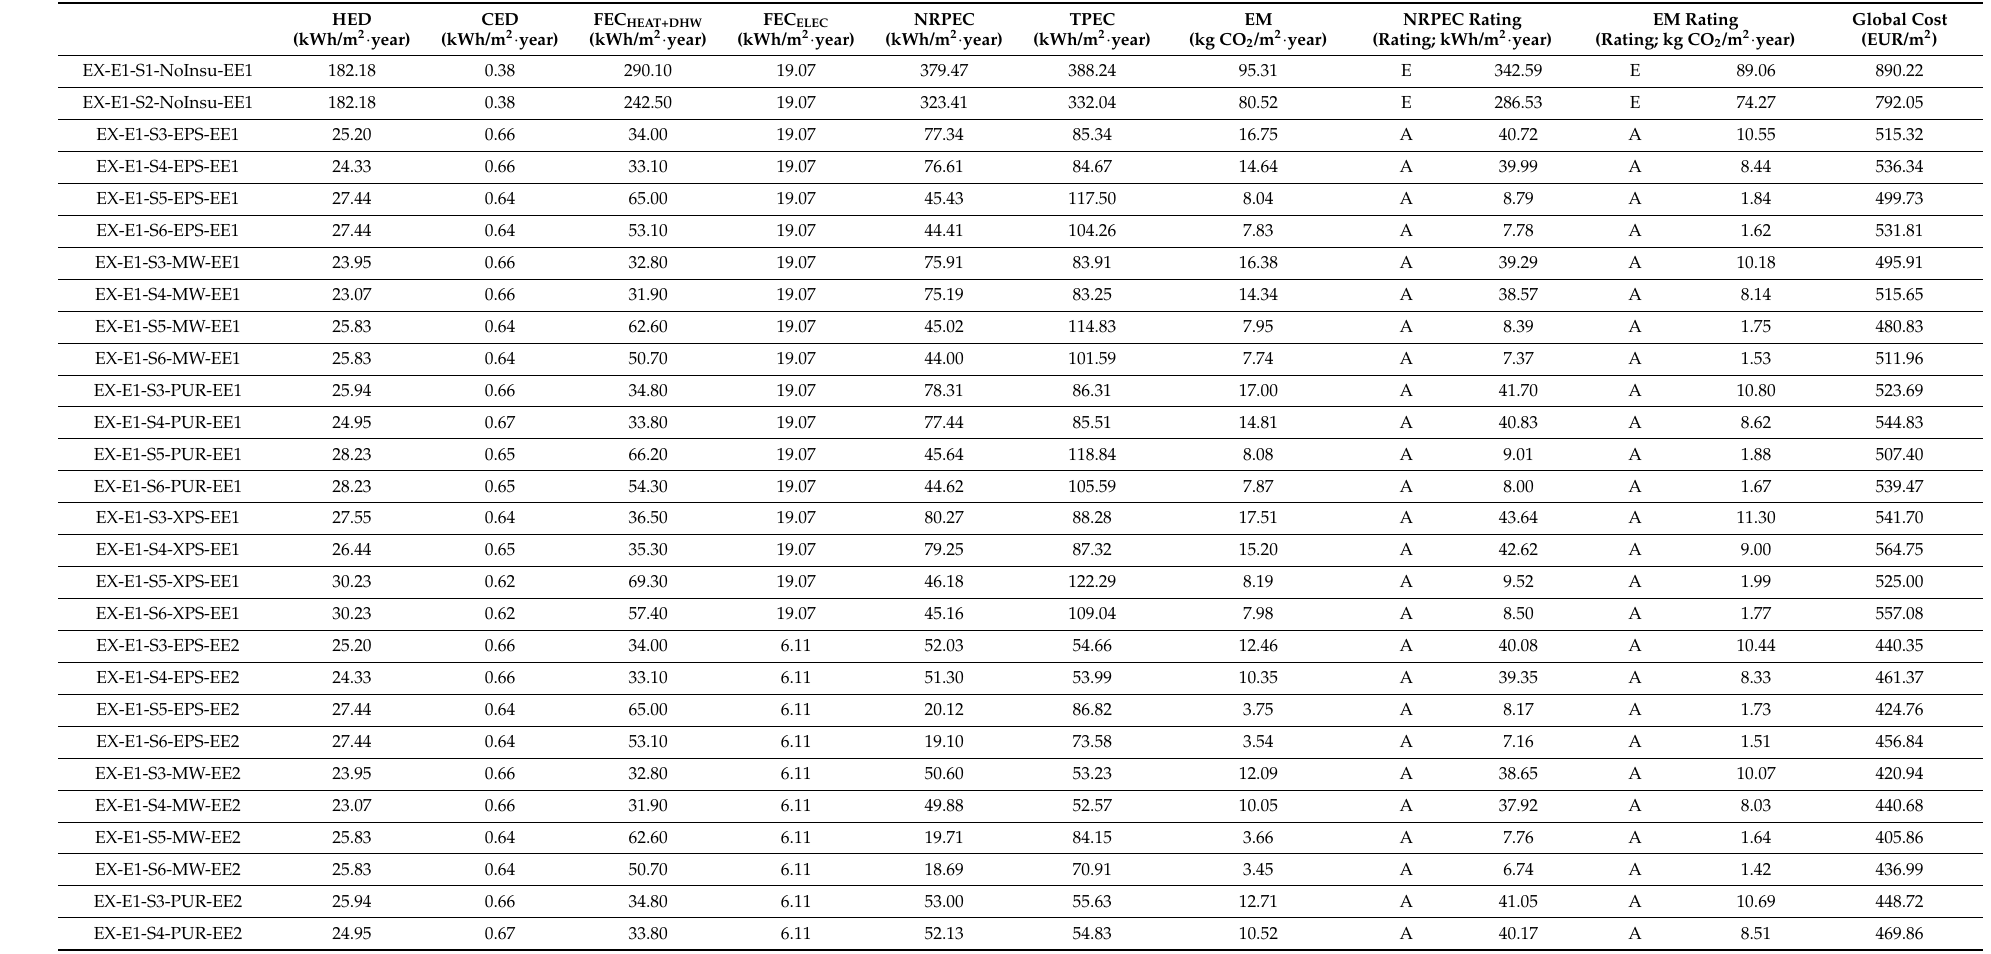
Table 8. Energy, environmental and economic impacts for each case study in San Mill á n de la Cogolla (CCZ